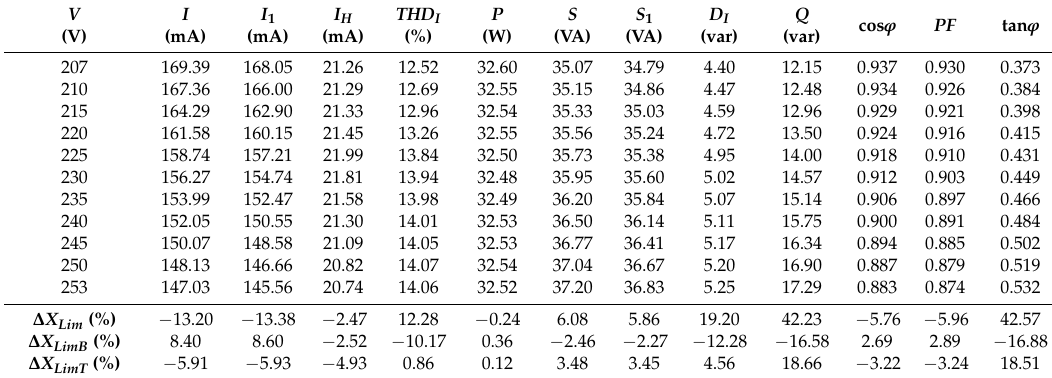
Table 2. Summary of the measured values of the electrical parameters of the lighting luminaires marked as LUM2.